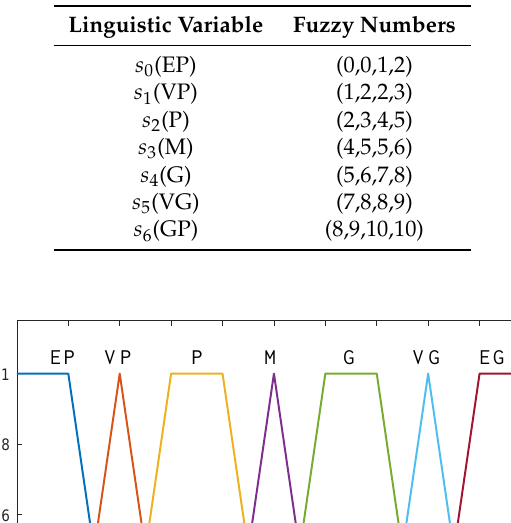
Table 18. Linguistic variables for the evaluation.